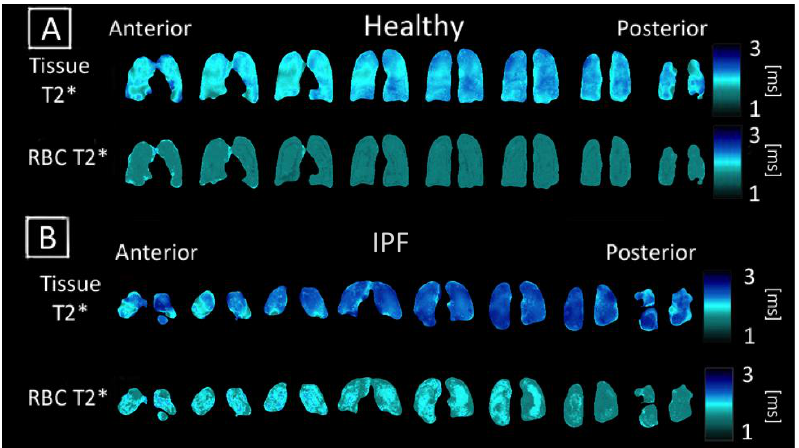
Figure 4. Coronal maps of 3D-SBCSI Tissue T2*, RBC T2* in ( A ) healthy subject H4 and ( B ) IPF subject I1.